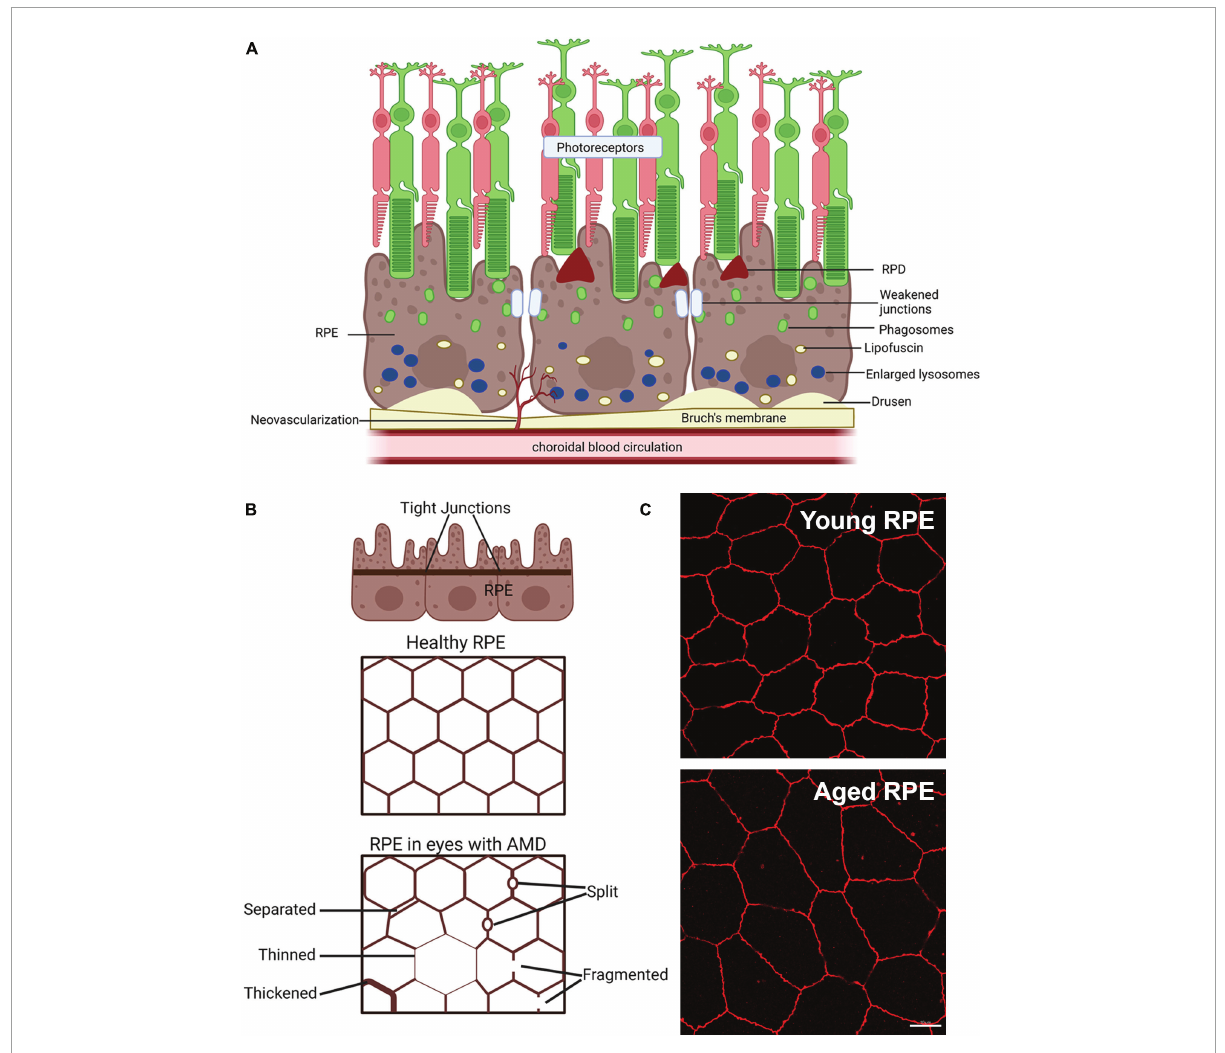
FIGURE2 Schematic of changes that occur in the retinal pigment epithelium (RPE) of age-related macular degeneration (AMD) patients. (A) Schematic of changes within the RPE in late-stage AMD, including weakening of tight junctions that form the blood retinal barrier, deposition of lipofuscin and enlarged failed lysosomes. Deposition of extracellular waste around the RPE, large drusen on the basal side of the RPE are apparent and reticular pseudodrusen (RPD) on the apical side may also manifest. (B) Schematic showing changes in the tight junctions of the RPE in AMD in flat mount view. Healthy RPE are hexagonal in shape and tight junctions form a continuous connection around each RPE cell. In AMD, RPE cells may be larger due to cell loss and tight junctions may be separated, thinned, thickened, split or fragmented, modified from Ach et al. (2015). (C) Example of the effects of aging on the mouse RPE. Tight junction ZO-1 labeling of young (3 month) and old (22 month) mouse RPE, shows increased RPE cell size in the aged tissue, suggesting cell loss with age. Some of this illustration was started from a BioRender Template and content and stylistic modifications were